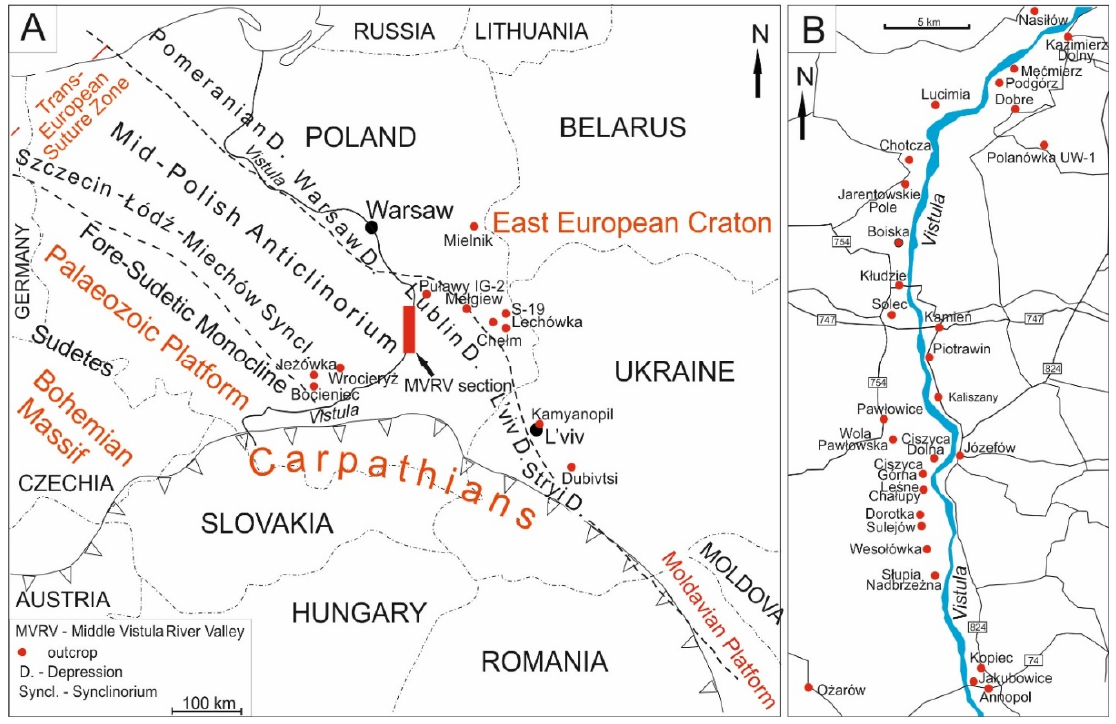
Figure 1. ( A ) Tectonic map sketch of Central Europe showing the location of the studied sections (after [37]); ( B ) geographical location of the sections in the Middle Vistula River Valley.